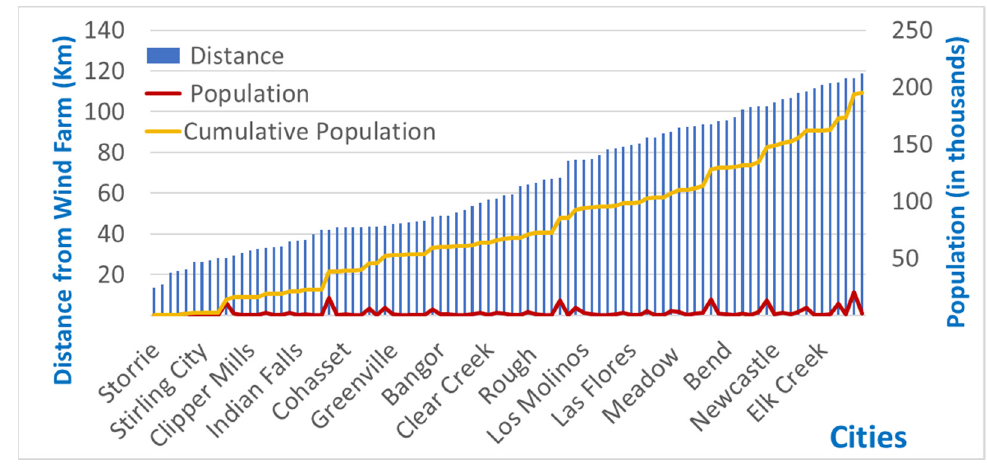
Figure 13. Analysis of distance and population for proposed onshore wind turbines in Northeast Figure 13. California.